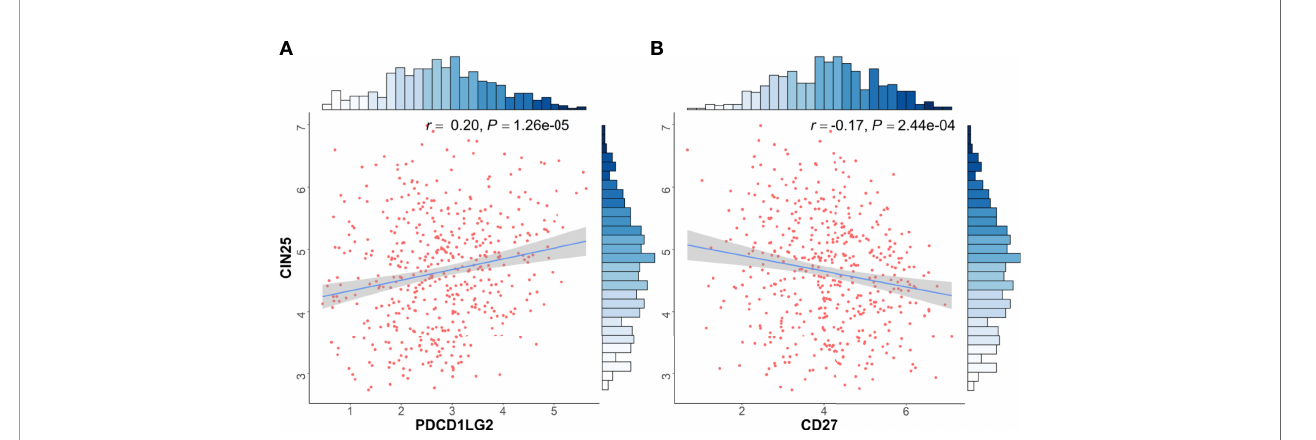
FIGURE 4 | Immune checkpoint associated genes expressions were associated with cancer invasion signature. Transcriptomic data from TCGA dataset was used in functional exploration. CIN25 score was applied as signature of cancer invasion according to previous literatures [15, 16]. (A) CD27 expression was negatively associated with CIN25 score (rho=-0.17, P =2.44E-04), (B) PDL2 expression was positively associated with CIN25 score (rho=0.20, P